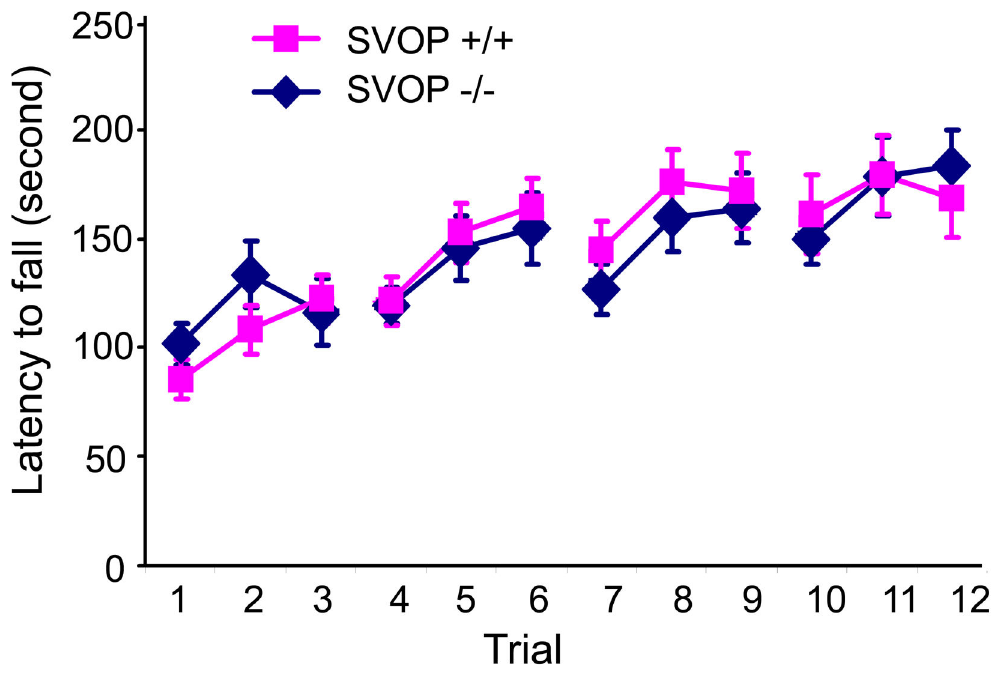
Figure 6. Loss of SVOP does not affect motor coordination. Mice were tested for motor coordination on the rotating rod. Twelve SVOP knockout (-/-) mice and 12 SVOP wild type (+/+) littermates were included in the test. Shown are average fall latencies across 12 trials (3 trials per day over 4 consecutive days). Each data point represents the group mean± SEM. Performance between groups did not differ (Students t test, p values ranged from 0.17 to 0.98 across trials, SAS software analysis (GLIMMIX) generalized linear mixed analysis of intra-individual correlation over time, P =0.90). Therefore, loss of SVOP did not affect motor